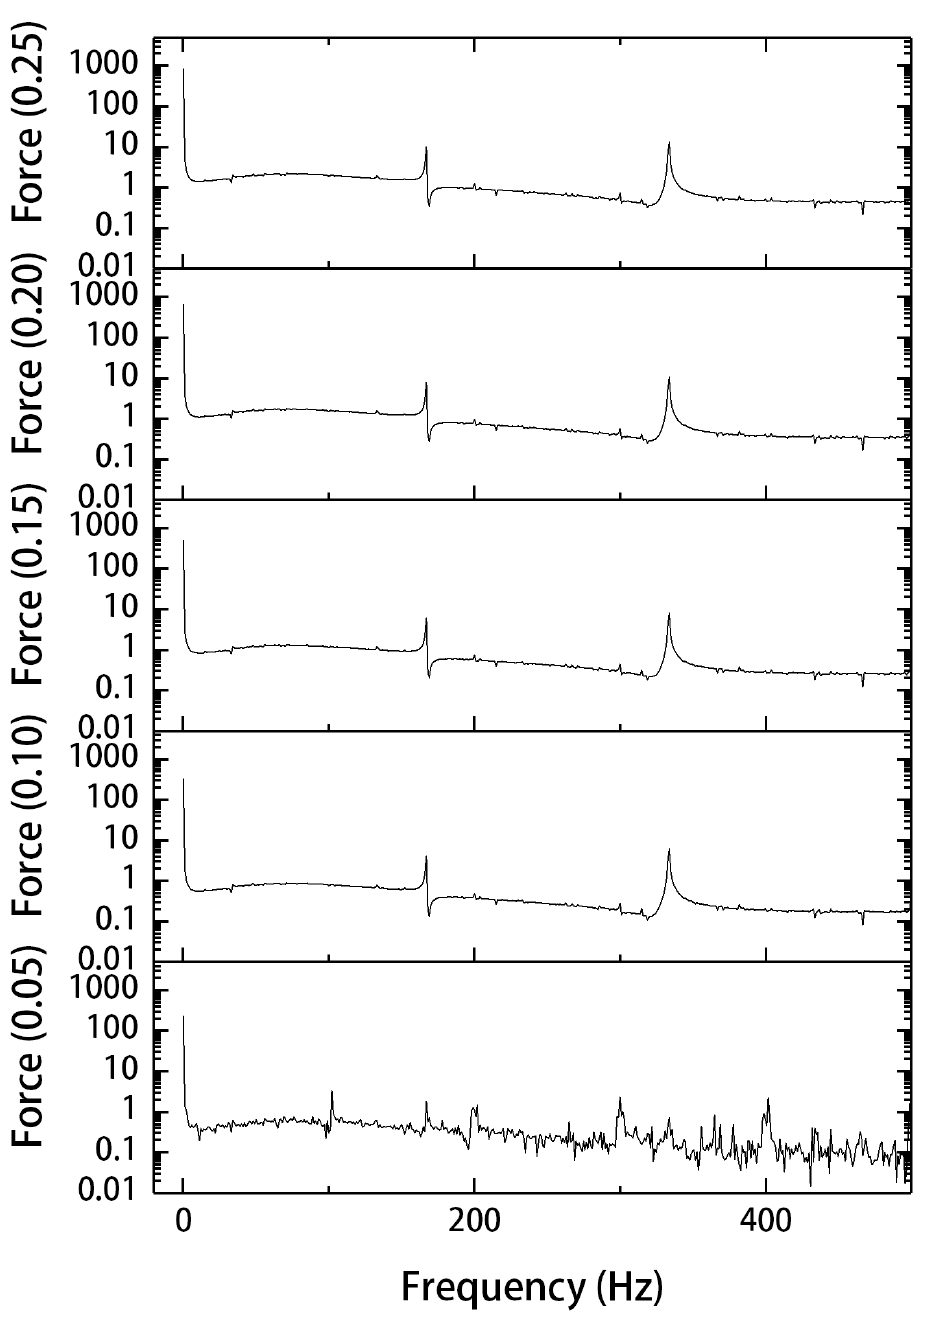
Figure 15. FFT transformation of